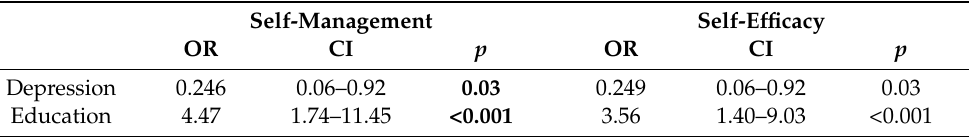
Table 8. Logistic regression analysis between depression and education levels and self-efficacy and